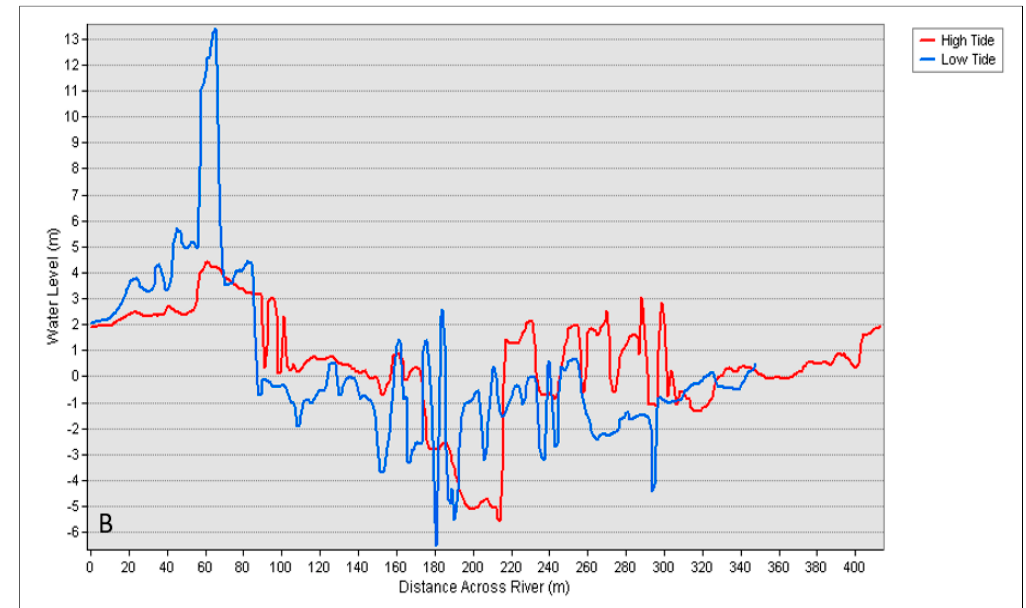
Figure 10. Water level profile ( A ) at cross Section 1; ( B ) at cross section 2.